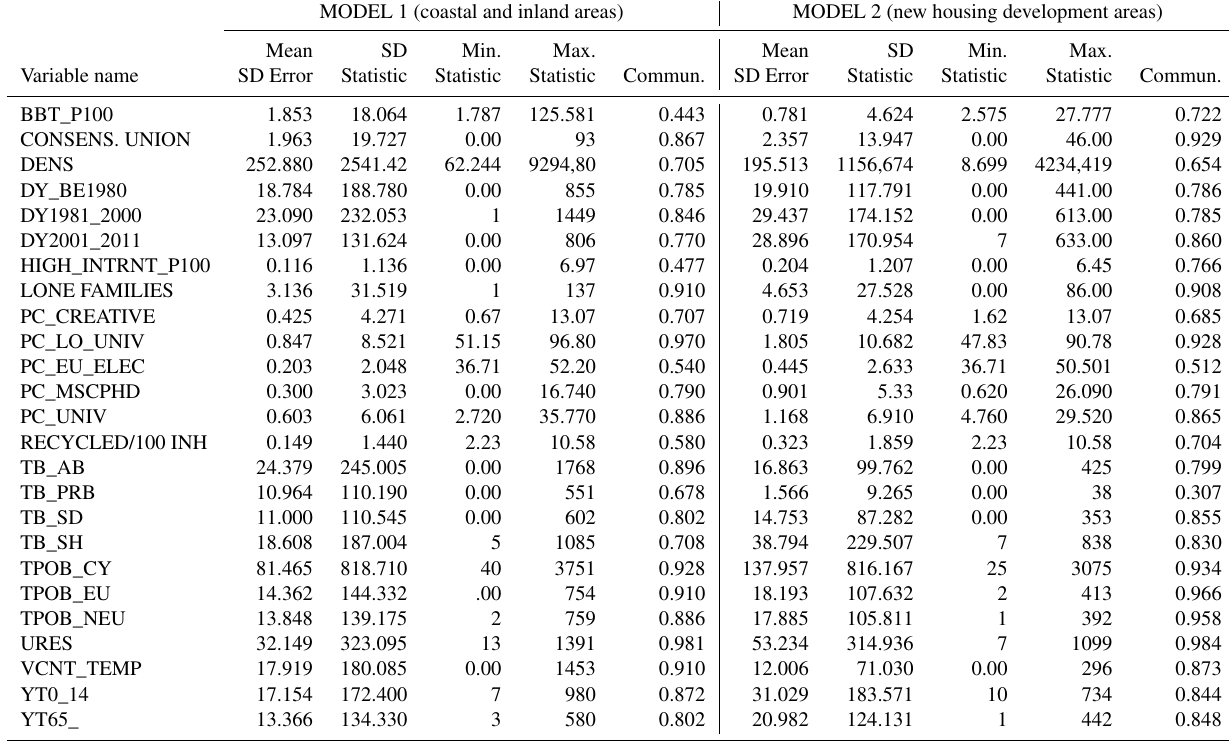
Table 3. Descriptive statistics of the variables employed in the models. MODEL 1 (coastal and inland areas) MODEL 2 (new housing development